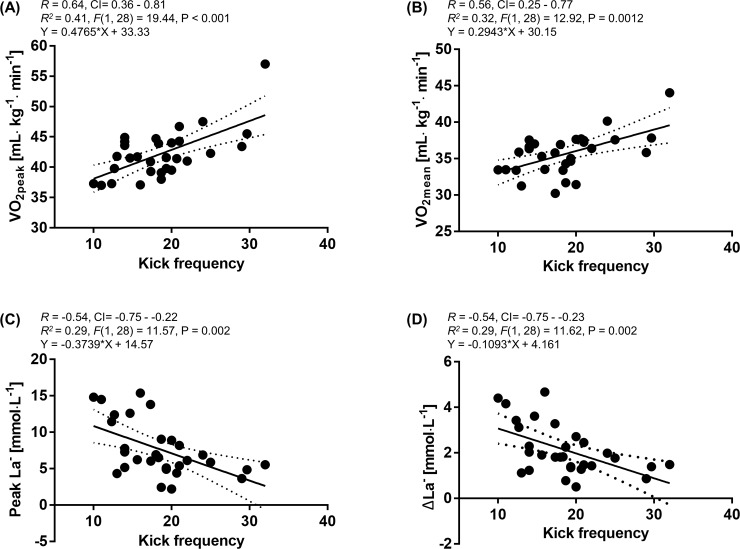
Pearson’s two-tailed correlation and linear regression between kick frequency (KF) and peak oxygen uptake (VO2peak), mean oxygen uptake (VO2mean), peak lactate (peak La-) and difference of lactate ΔLa-.(A) Moderate positive correlation and linear regression between KF and VO2peak (B) Moderate positive correlation and linear regression between KF and VO2mean (C) Moderate negative correlation and linear regression between KF and peak ΔLa- (D) Moderate negative correlation and linear regression between KF and peak La-.